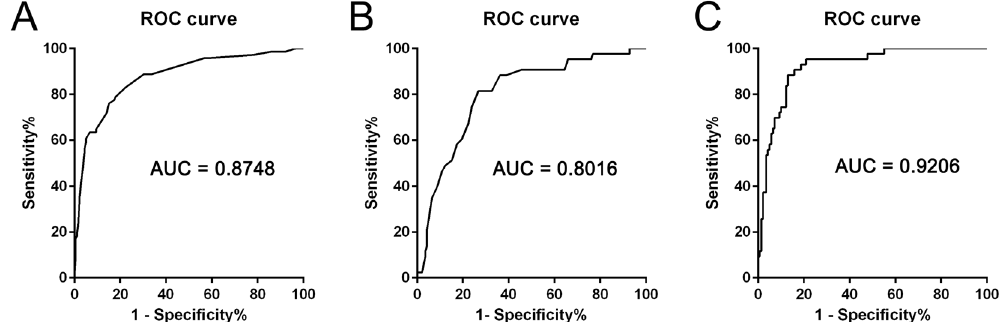
Figure 2. The ROC curve analysis of different indexes for differentiating hemorrhagic MMD or MMS from non-hemorrhagic MMD or MMS. ( A ) ROC curve analysis of age, gender, Suzuki stage (Suzuki 3–4), dilation of AChA (Grade 2) and PComA (Grade 2), and aneurysm for predicting hemorrhagic MMD or MMS (P < 0.0001, AUC = 0.8748). ( B ) ROC curve analysis of F-V ratio (the ratio of CFCT to CVCT) for predicting hemorrhagic MMD or MMS (P < 0.0001, AUC = 0.8016, best cut-off point 0.4344; sensitivity 81.4%, specificity 73.2%). ( C ) ROC curve analysis of the F-V ratio, combined with age, gender, Suzuki stage (Suzuki 3–4), dilation of AChA and PComA and aneurysm, for predicting hemorrhagic MMD or MMS (P < 0.0001, AUC =